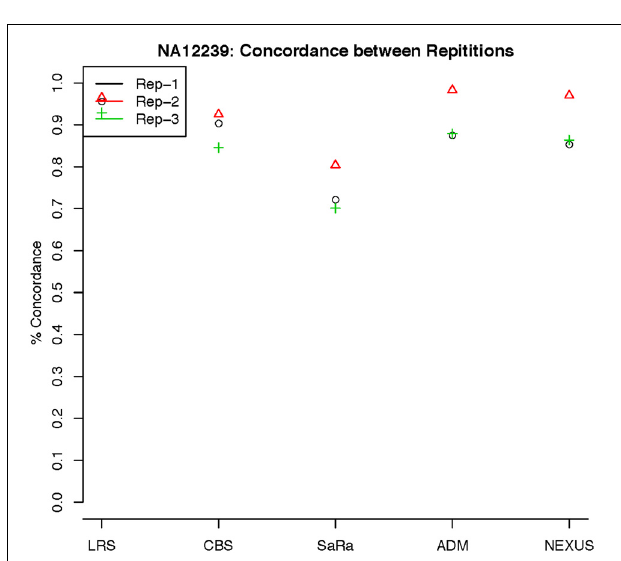
FIGURE 9 | This is % Concordance between methods for HapMap sample NA18517. Percent concordance is defined as the number of probes called as a CNV on two algorithms divided by the geometric mean of the total number of probes called significant by the two algorithms.